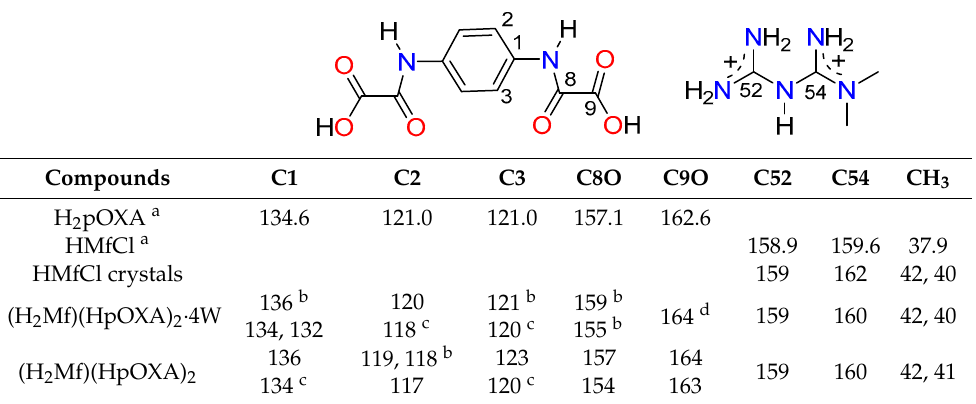
Table 5. CPMAS and isotropic 13 C chemical shifts of H 2 pOXA, HMfCl, H 2 Mf(HpOXA) 2 · 4W and H 2 Mf(HpOXA) 2 .